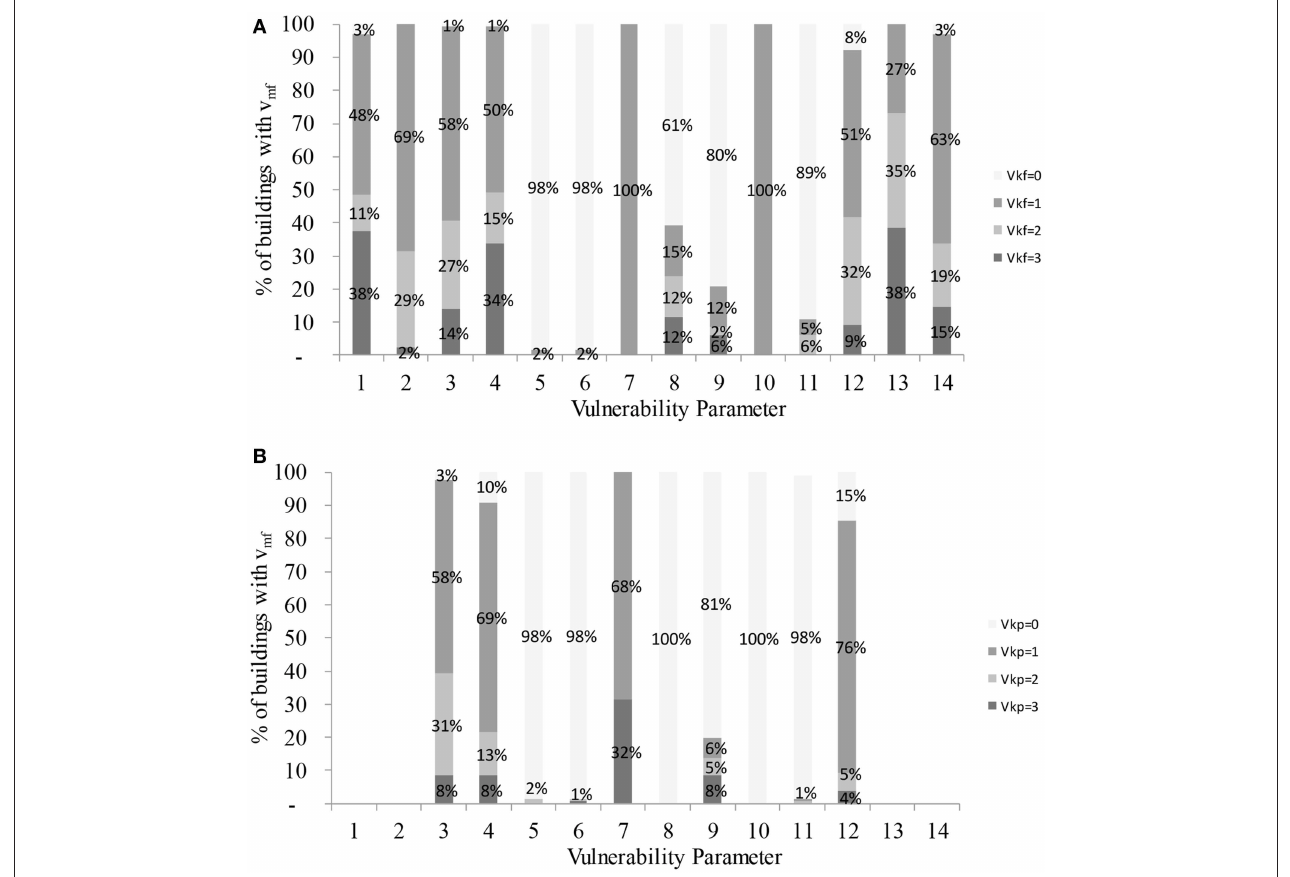
FIGURE 9 | Distribution of the (A) fragility and (B) protection scores for the buildings of